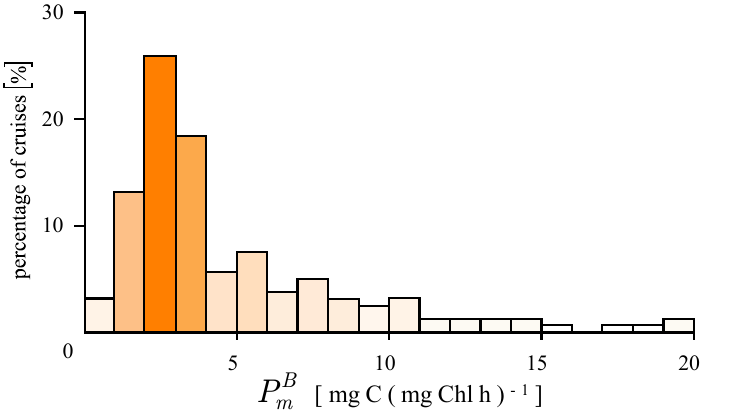
Figure 2. Histogram of estimated values of the assimilation number P B m obtained from 185 cruises in the Adriatic Sea. The abscissa corresponds to parameter value, and the ordinate gives the percentage of cruises that fall into a certain interval of parameter